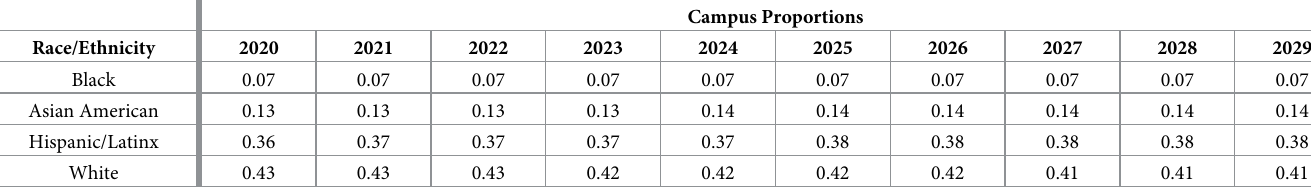
Table 3. Critical mass projections for University of California-Berkeley. These proportions specify the enrollment level necessary to reflect a racial/ethnic group’s repre- sentation given the institution’s location and available applicant pool; see formula in (18). These proportions are relative to each other as our model accounts for only four racial/ethnic groups. This restriction stems from limitations in the availability of